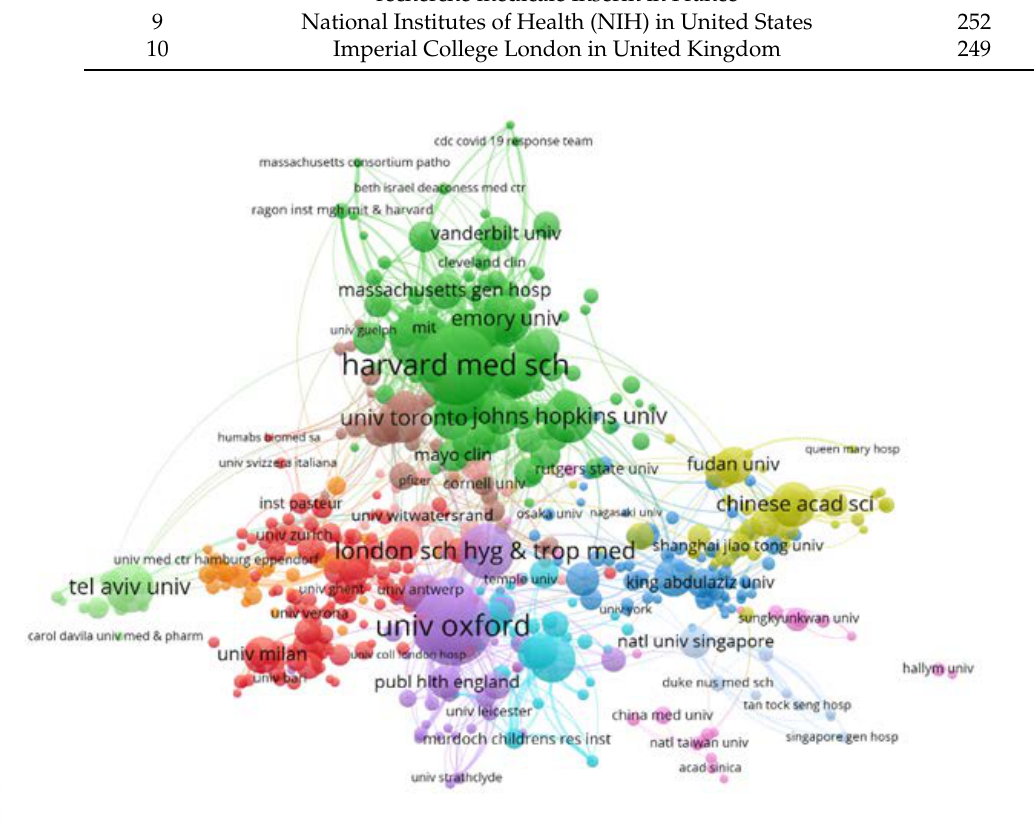
Figure 6. The cooperation chart for institutional affiliations, using network visualization through VOSviewer.